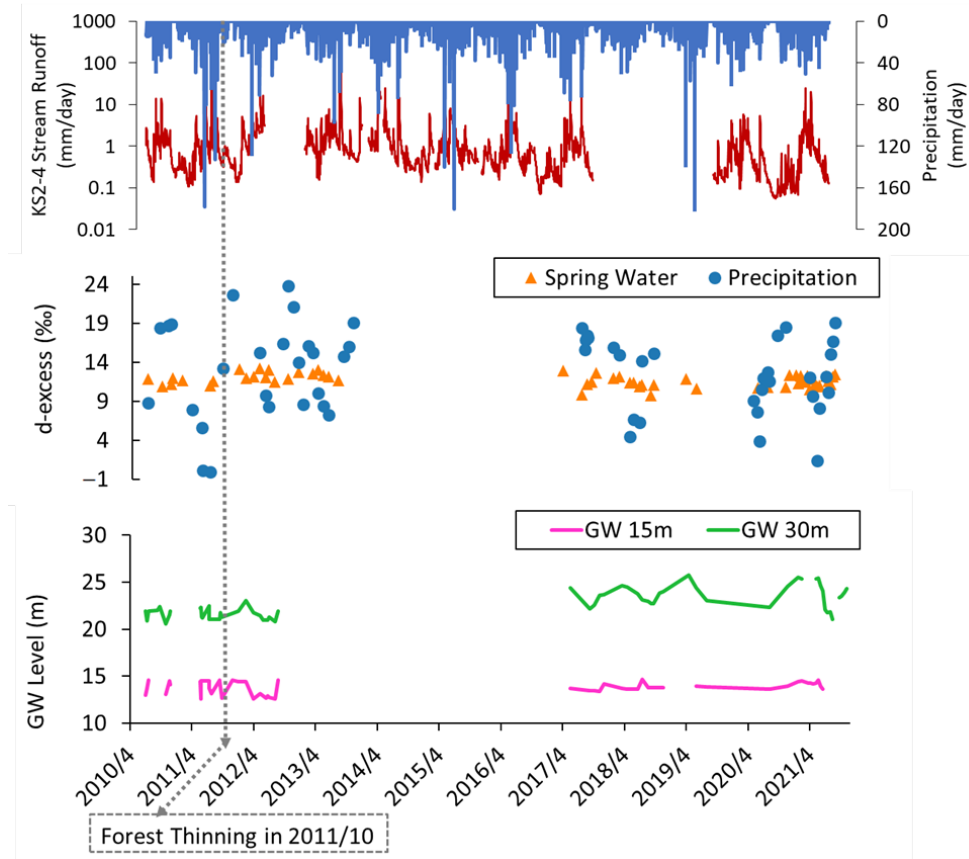
Figure 3. Stream water precipitation and runoff measurements, groundwater (GW) levels measured in the two boreholes, and spring water d-excess (‰) during the observation period (June 2010–November 2021). The forest was 50% thinned in October 2011.